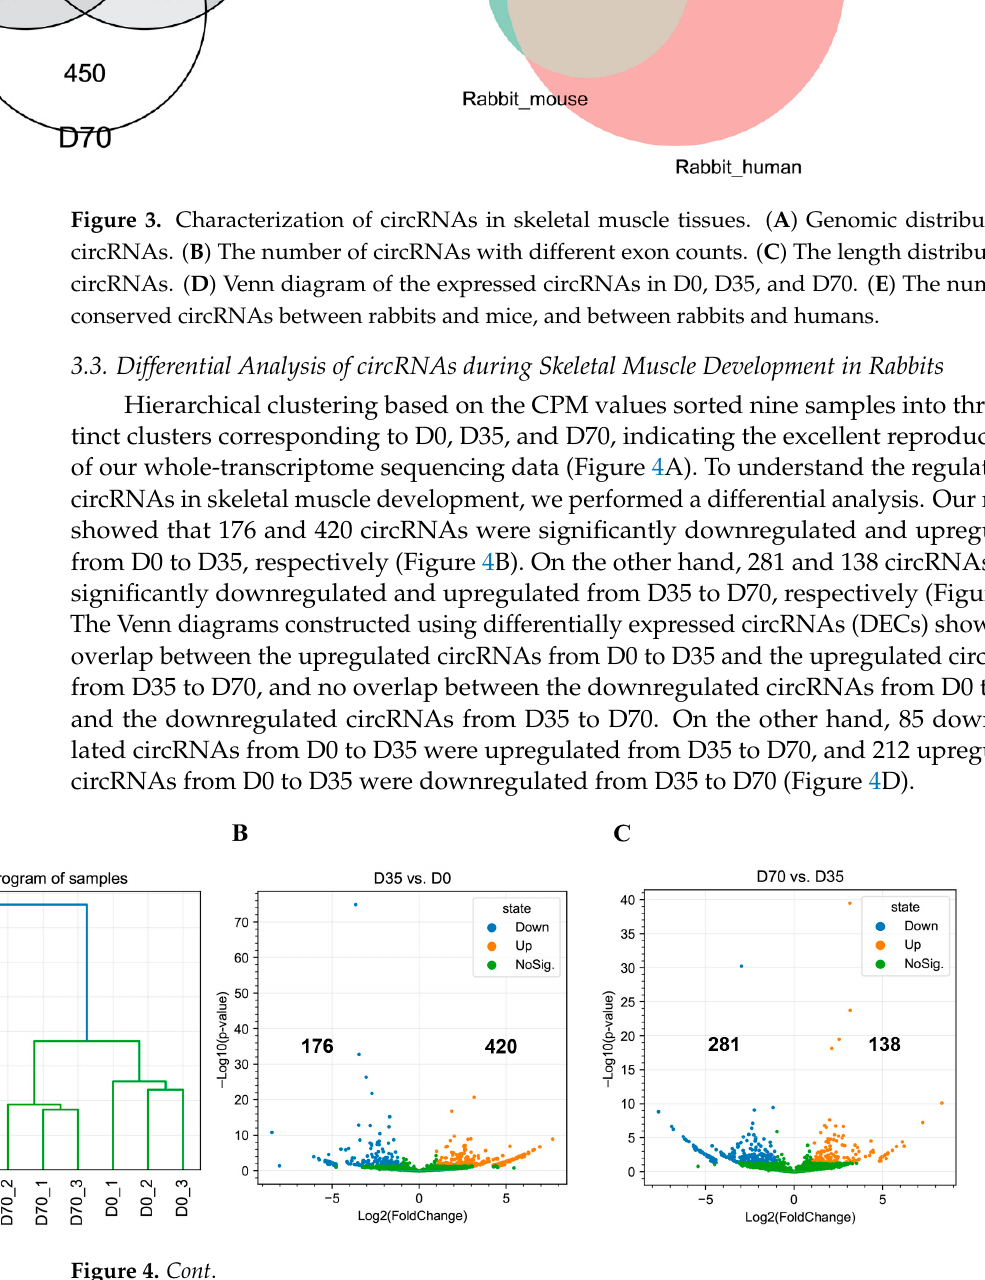
Figure 4. Differential analysis of circRNAs during skeletal muscle development of rabbits. ( A ) Hi- erarchical clustering analysis of nine samples with all identified circRNAs based on the CPM values. ( B ) Volcano plot of DECs in D35 vs. D0. ( C ). Volcano plot of DECs in D70 vs. D35 ( D ) Venn diagram showing the DECs at the two growth periods. 3.4. The Expression Relationships between circRNAs and Their Hose Genes The DECs and DEmRNAs were subjected to an expression relationship analysis be- tween circRNAs and their host genes. From D0 to D35, 34 and 113 circRNAs were syn- chronously changed with their downregulated and upregulated host genes, respectively (Figure 5A). GO enrichment showed that neural tube development, secondary metabolic process, and retrograde transport and endosome to Golgi were the top three significantly enriched GO-BP terms by the host genes of those upregulated circRNAs. A KEGG path- way analysis showed that the MAPK signaling pathway, Ras signaling pathway, and Rap1 signaling pathway were the top three significantly enriched signaling pathways by the host genes of those upregulated circRNAs (Figure 5B). From D35 to D70, 57 and 29 circRNAs were synchronously changed with their downregulated and upregulated host genes, respectively (Figure 5A). GO enrichment showed that the polysaccharide biosyn- thetic process, regulation of signaling receptor activity, and polysaccharide metabolic pro- cess were the top three significantly enriched GO-BP terms by the host genes of those upregulated DECs. A KEGG pathway analysis showed that the choline metabolism in cancer, fatty acid biosynthesis, and selenocompound metabolism were the top three sig- nificantly enriched signaling pathways by the host genes of those upregulated circRNAs (Figure 5C). In contrast to those synchronously changed between DECs and DEmRNAs,